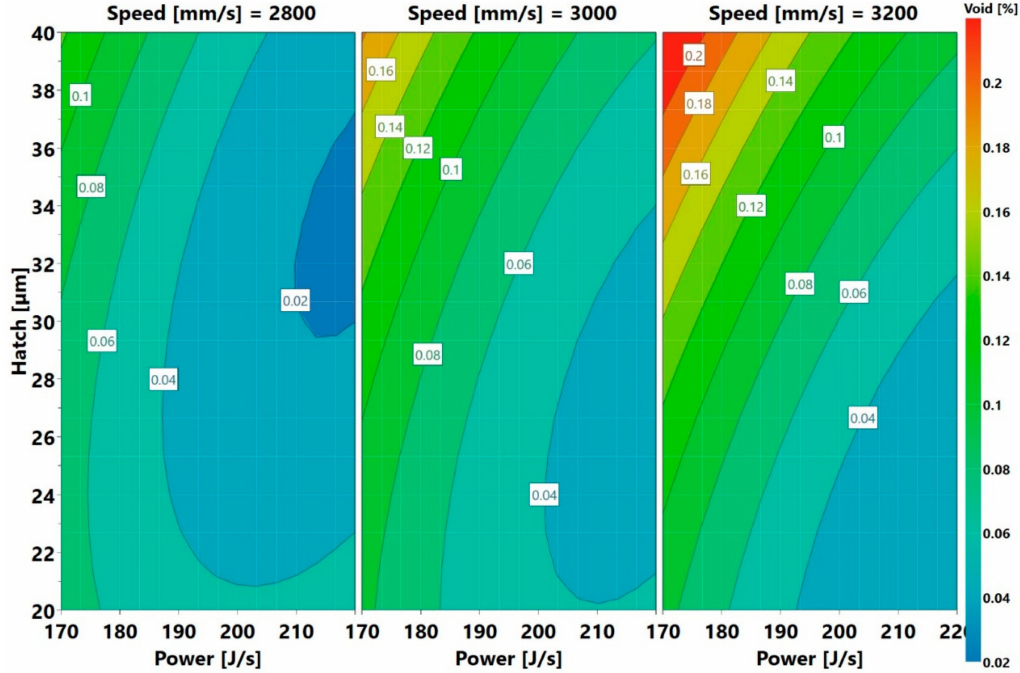
Figure 20. Void contour plots providing predictions of where low void fraction is likely to be present. The plot shows the variation of hatch distance with power at three di ff erent speeds. The lines of constant voids are marked on the plot. The operating window of low void content, for example areas with a void content of less than < 0.04 (colored light blue and dark blue), are observed at the right-hand side of every speed plot. The area moves from the bottom right at a speed of 3200 mm / s upwards as the speed reduces. Thus, the lowest voids were found at the high power lines of 2800 mm / s speed. Notice that the low void content region extended almost throughout the length of the hatch axes. The plot also shows that low void content areas could be found outside the present parameter windows. This region should be within the blue colored region, away from the right side of the contour maps. An example of a prediction of a new process parameter set that is likely to produce a low void content is 240 J / s, 2800 mm / s, and 30 µ m. Reducing the speed to 2600 mm / s and operating at the present power and hatch values are also likely to increase the blue area. It should, however, be remembered that speed had a lesser influence than power in the void content, as displayed in Figure 5. The prediction using the low void content approach implies that there would be cracks remaining. These cracks, anyway, would have to be removed by some viable methods. As the high stresses prevalent in the L-PBF process are one of the main causes of cracking, methods that reduce the stress could eliminate the cracks. This can be achieved, for example, by preheating the substrate, as proposed in [35]. Hot isostatic pressing (HIP) has also been demonstrated to close the cracks as seen from microstructure evaluations [13,25,36]. However, the creep life of HIPed L-PBF samples is very low, when compared to cast parts, even after undergoing solutioning and ageing heat treatments [2]. This suggests that the cracks may not be fully closed or that the regions of the cracks may have low ductility. The eventual solution to this problem may involve compositional modification. An example of such modification in Inconel 738LC was proposed in [37]. The second approach of lowering the crack density is considering the 4D contour plots for crack density, as displayed in Figure